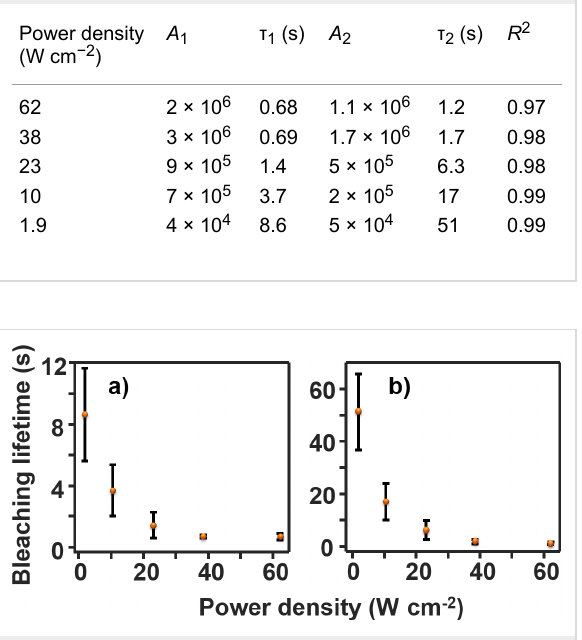
Figure 6: (a) The fast component of the bleaching lifetime for YOYO–DNA as a function of power density. (b) The slow component of the bleaching lifetime for YOYO–DNA as a function of power densi- ty. The error bars represent the standard deviation between at least 20 DNA for two